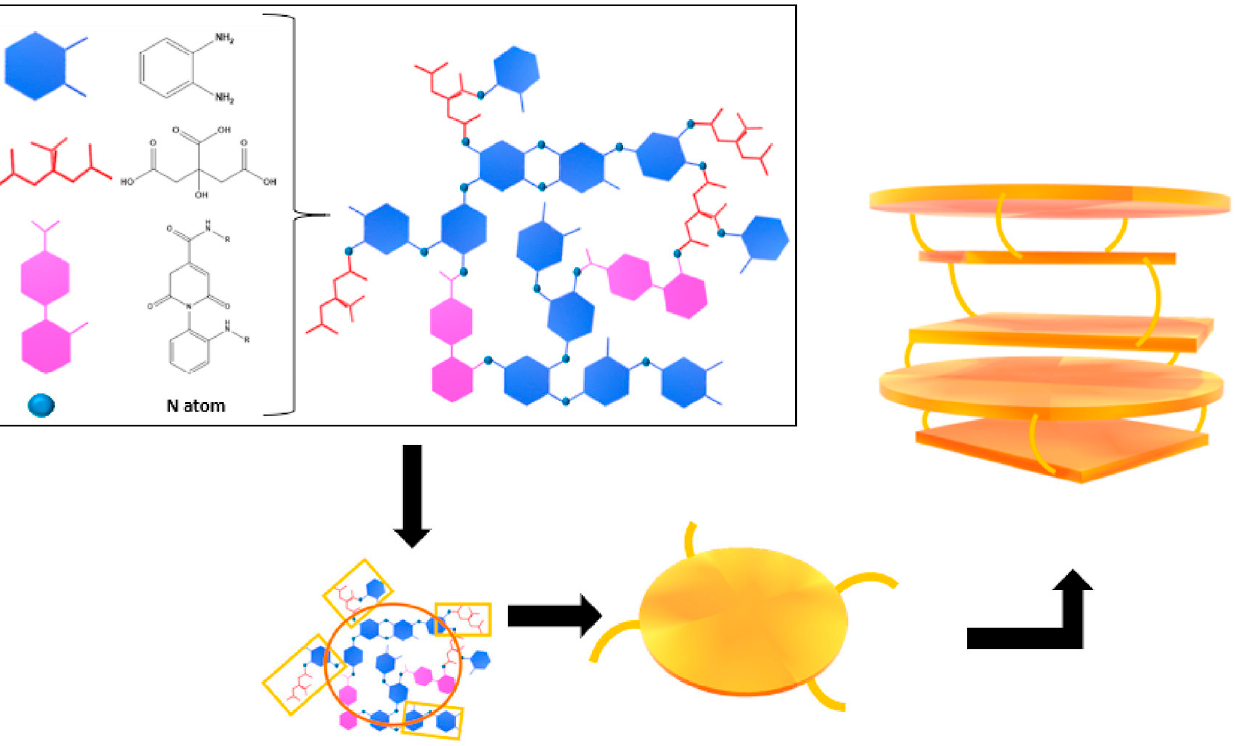
Figure 7. Schematic structure of PCDs produced using 1,2-diaminobenze and citric acid. Reprinted with permission from Mintz et al. [109].